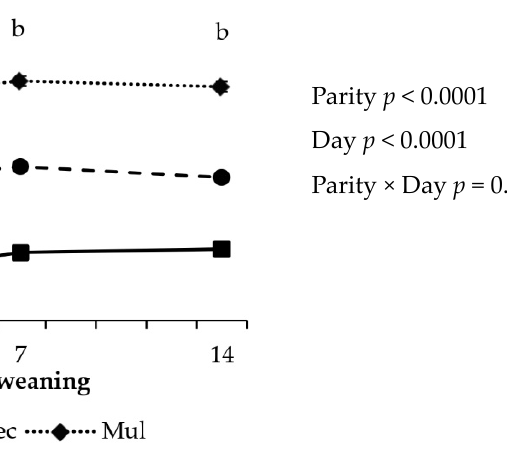
Table 2. Effect of parity on physiological measurements in Nellore cows at abrupt weaning.